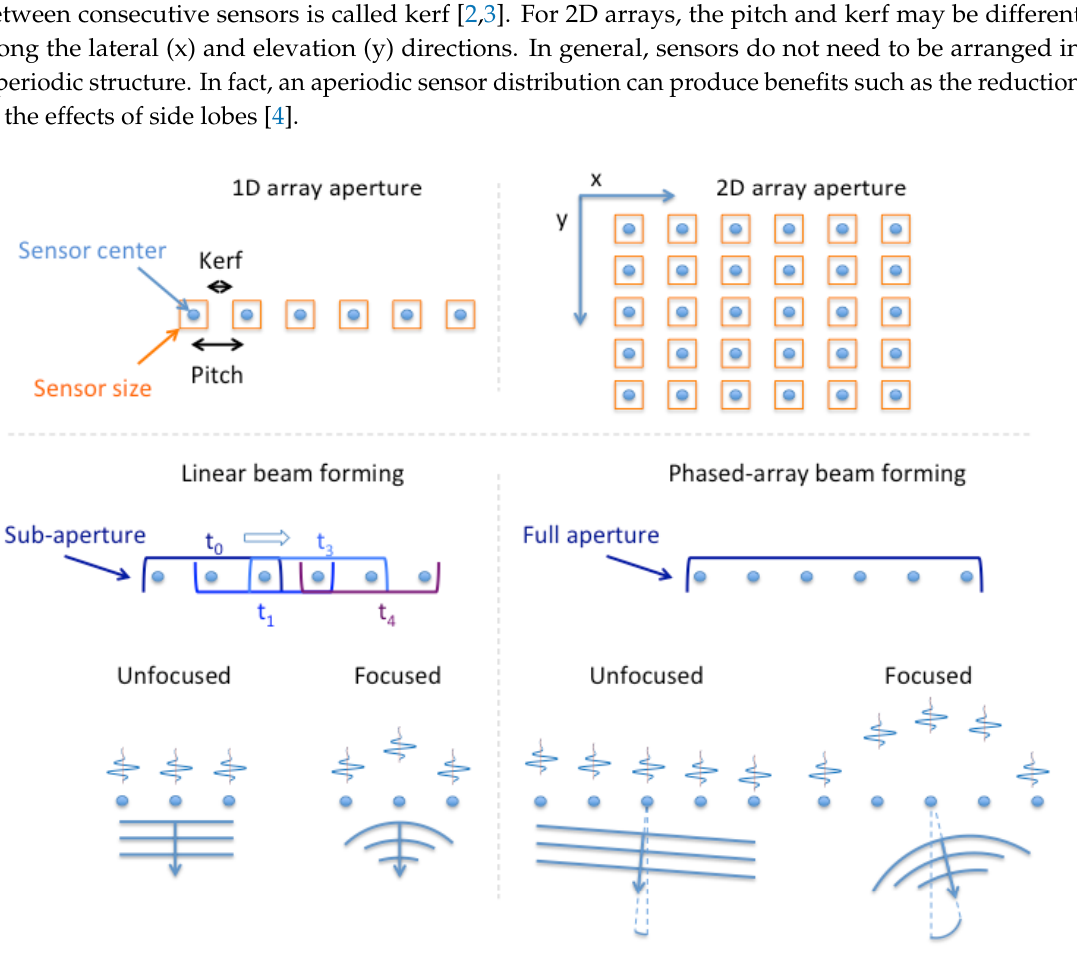
Figure 1. This figure shows the different sensor distributions for a one-dimensional (1D) and two-dimensional (2D) array aperture (top), together with an overview of the possible driving schemes for linear and phased array beam forming (bottom) in cases with a focused and an linear and phased array beam forming (bottom) in cases with a focused and an unfocused unfocused beam.